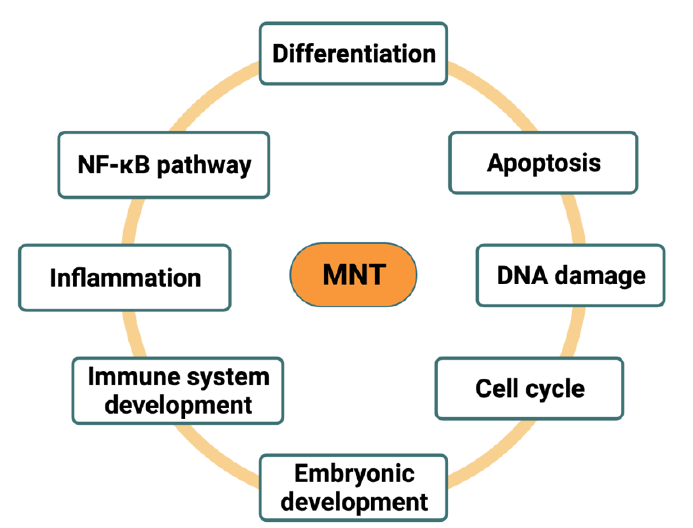
Figure 6. Cellular functions of MNT. MNT is involved in several cellular functions, including differentiation, apoptosis, DNA damage, cell cycle, embryonic development, immune system development, inflammation, and NF- κ B pathway regulation. Depending on the model, MNT will either antagonize or cooperate with MYC.